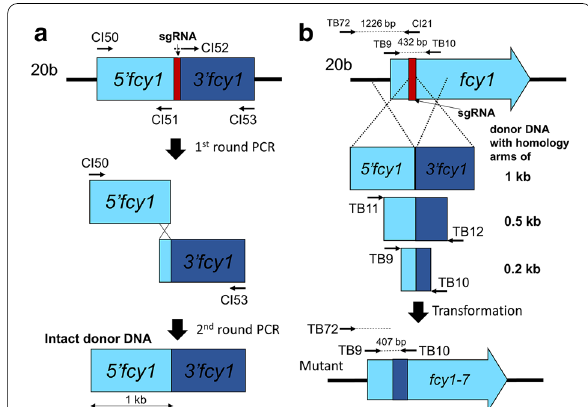
Fig. 1 Targeted gene replacement using homologous recombination along with CRISPR/Cas9. a A schematic diagram of the procedure used to construct the donor DNA template that lacks the sgRNA sequence for homologous recombination. b A schematic diagram showing the method for fcy1 mutation using CRISPR/Cas9 and donor DNA. PCR fragments with around 1 kb, 0.5 kb, and 0.2 kb each of right and left homologous arms were used as donor DNA temples. Black arrows display the primer pairs used for the PCR experiments in Additional file 1: Fig.